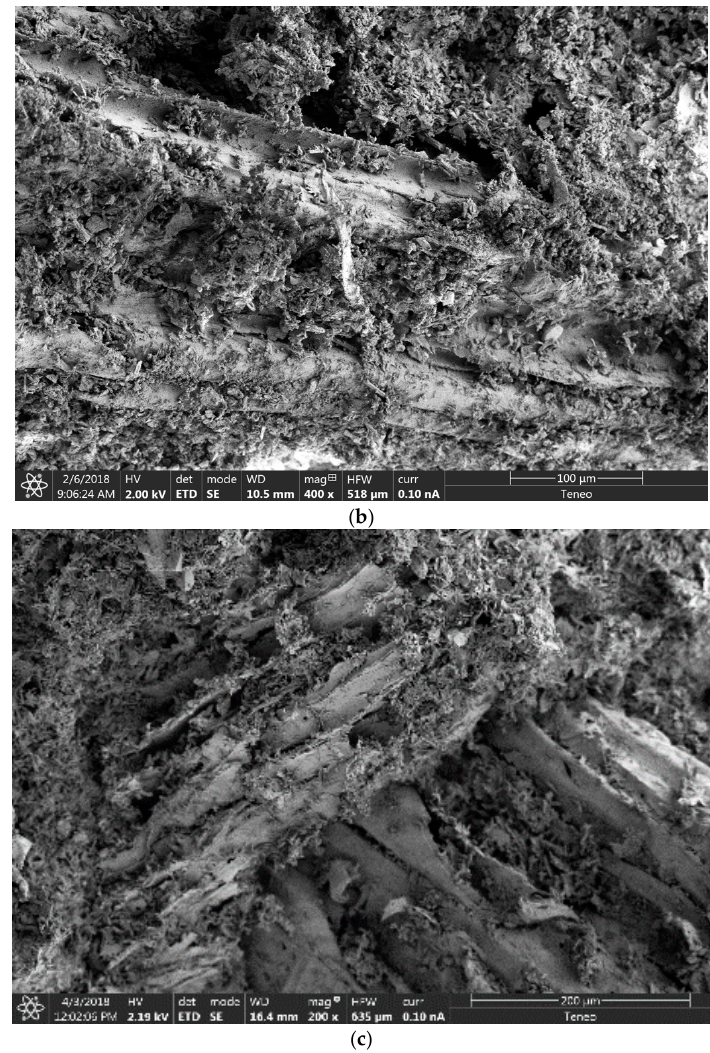
Figure 15. S20 SEM Analysis. ( a ) Five cycles; ( b ) 10 cycles; ( c ) 15 cycles.